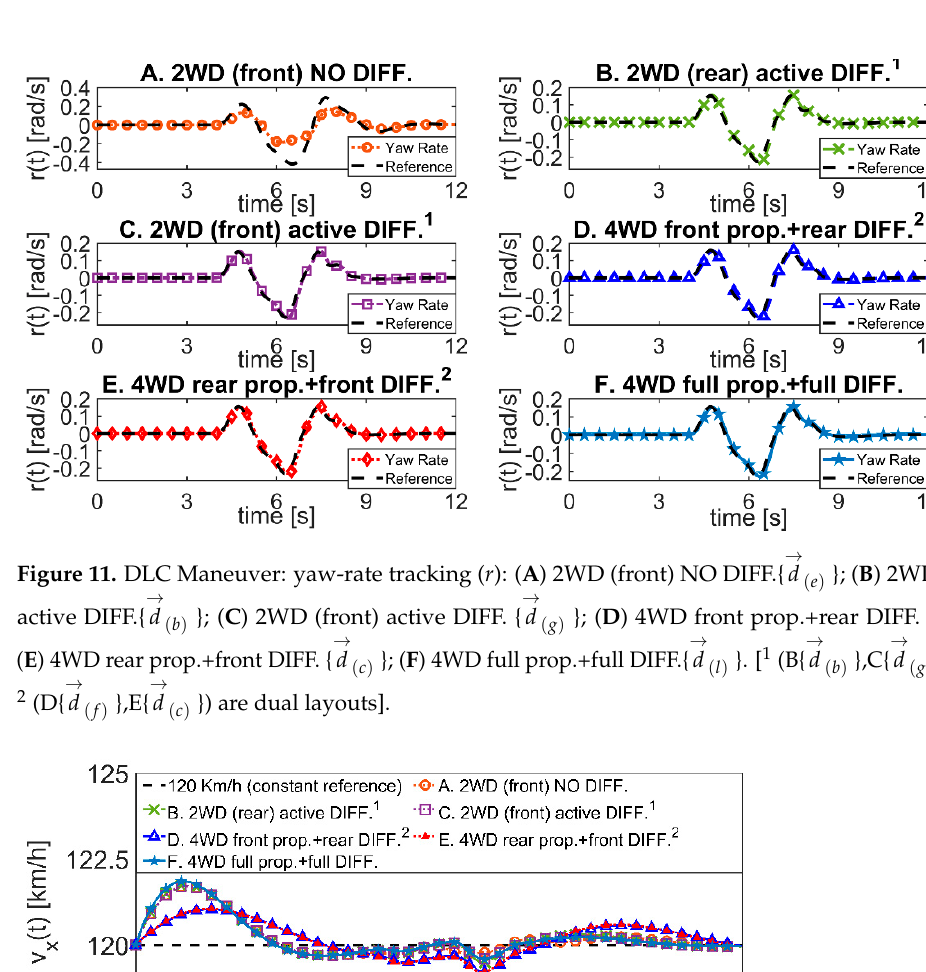
Figure 10. DLC Maneuver: driver steering effort in six driving configurations. [ 1 (B{ 𝑑⃗ ((cid:3029)) },C{ 𝑑⃗ ((cid:3034)) }) and 2 (D{ 𝑑⃗ ((cid:3033)) },E{ 𝑑⃗ ((cid:3030)) }) are dual layouts].